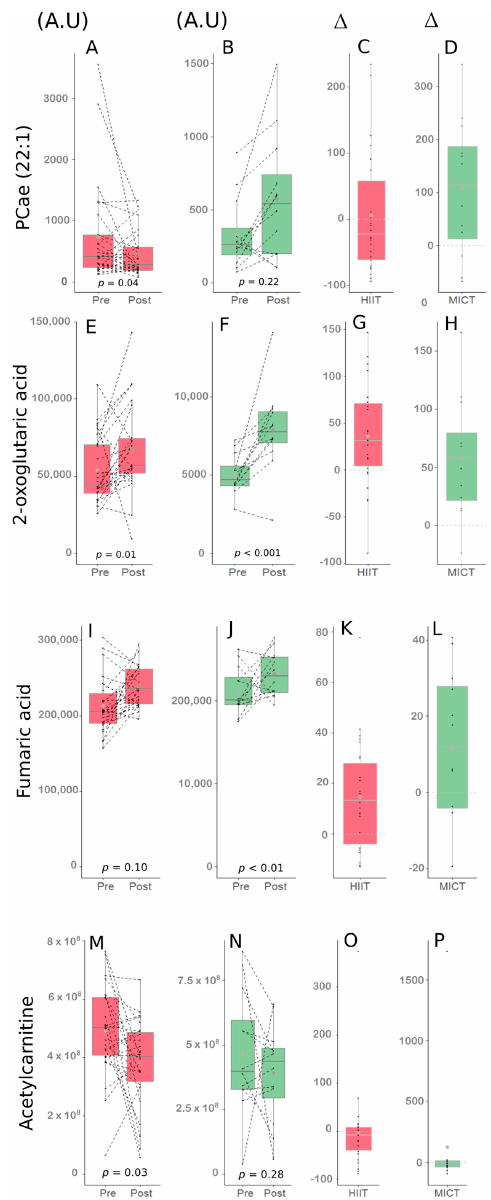
Figure 4. Impact of HIIT and MICT on the four metabolites of interest. HIIT: high-intensity interval training (red), MICT: moderate-intensity continuous training (green), Pre: before the 12-week